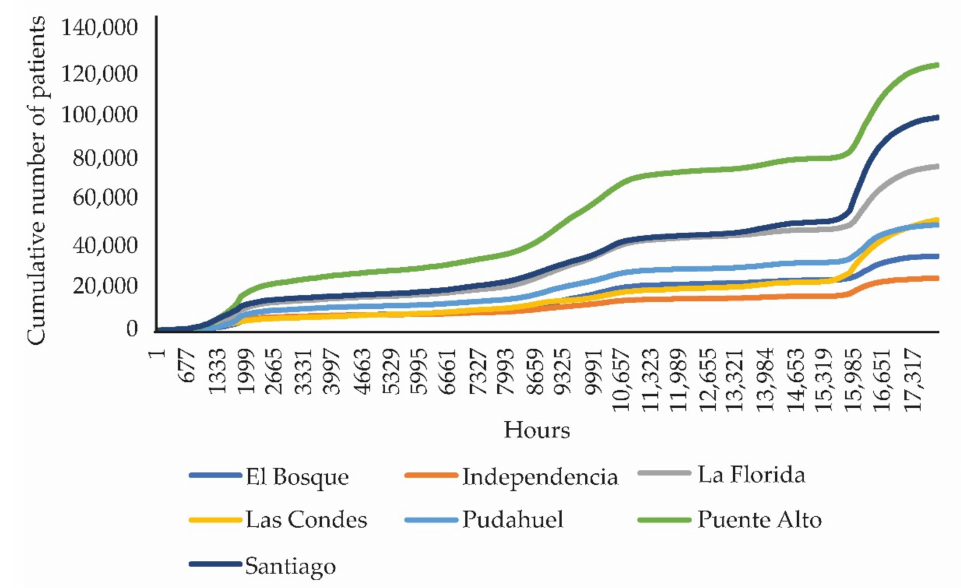
Figure 5. Hourly accumulated sick people, at seven communes of the study